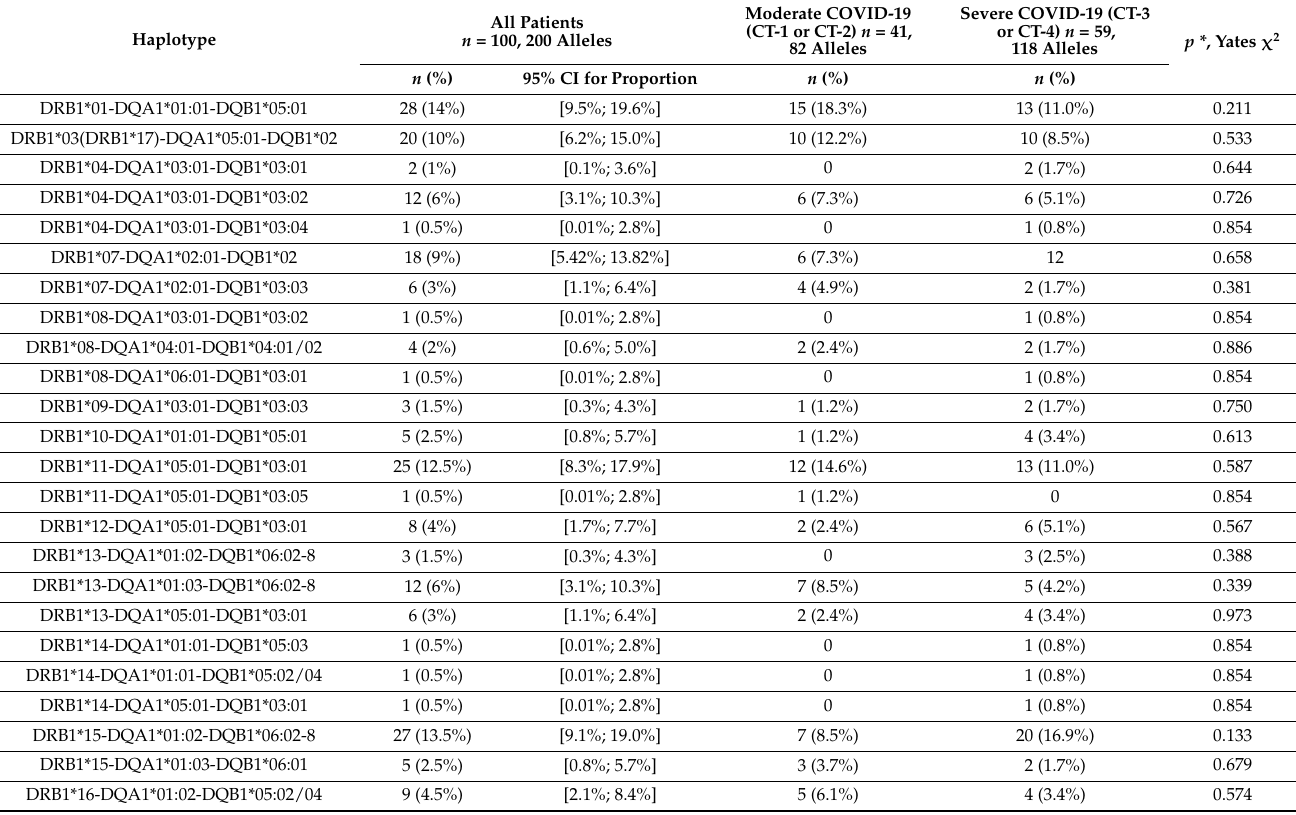
Table 5. HLA typing: frequencies of haplotypes of class II HLA genes in the entire cohort of patients and in the groups with moderate and severe